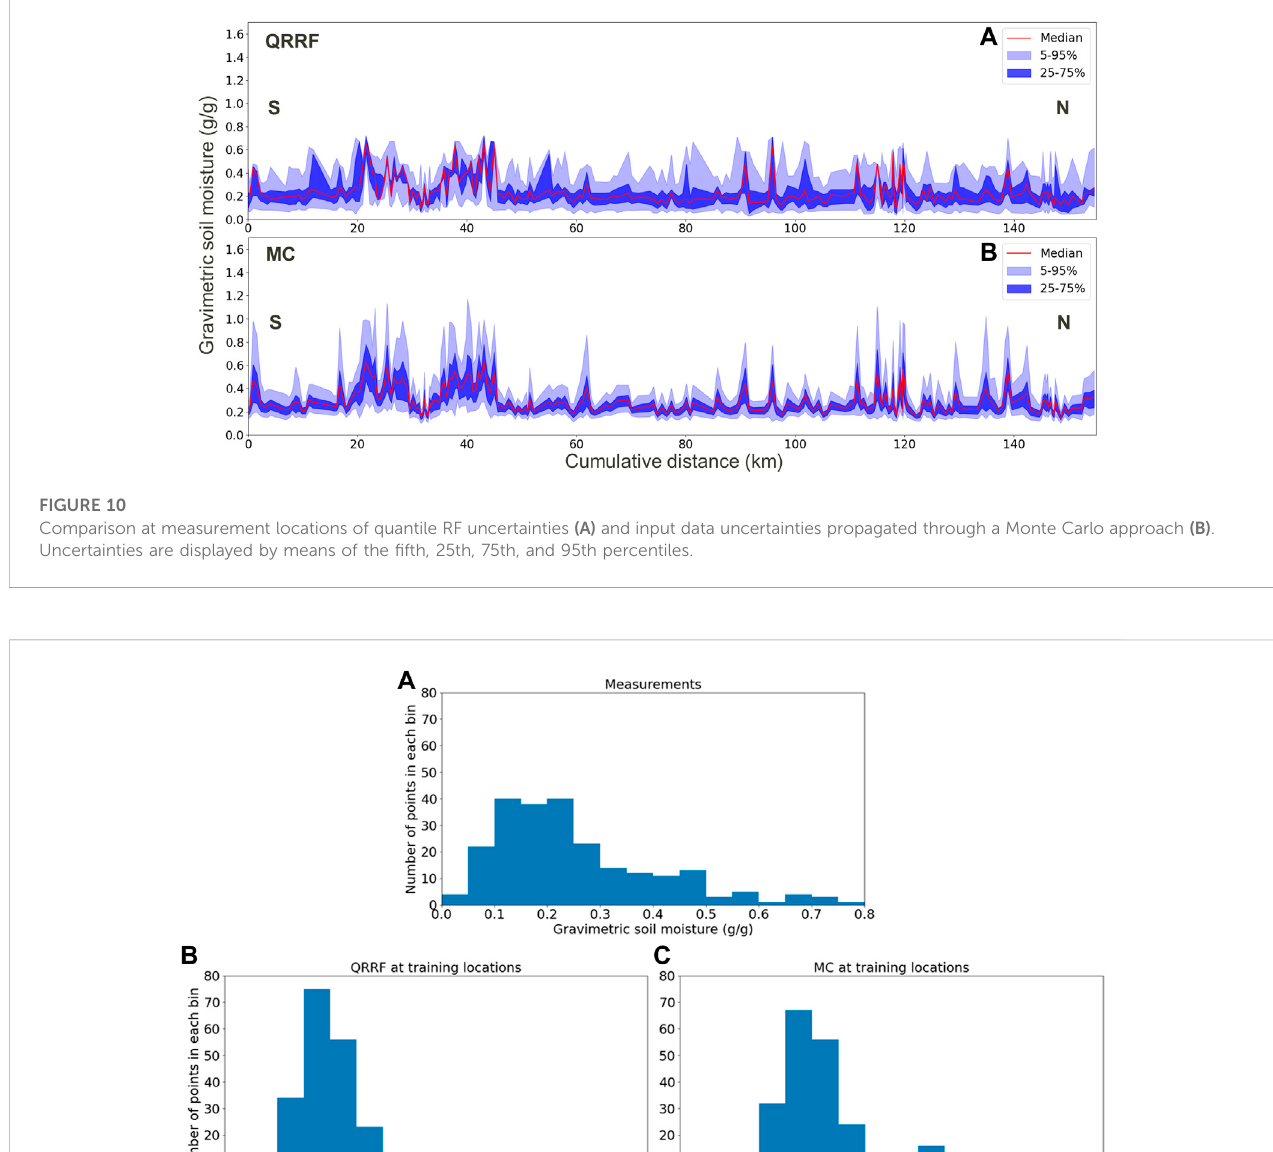
Frontiers in Environmental